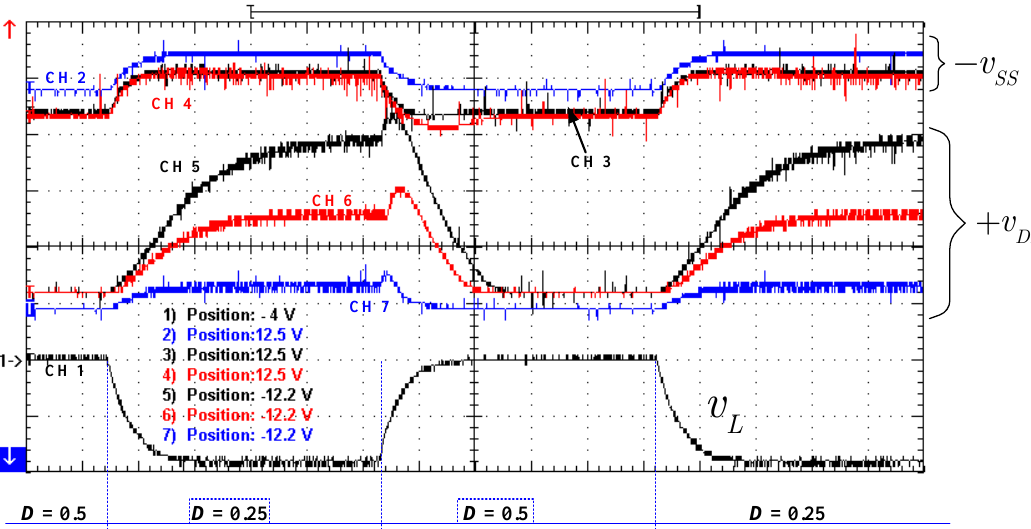
Figure 11. Vertical scale CH 1: 2 V/div, zero position – 4 V. Vertical scale CH 2 – CH 4: 200 mV/div, zero position 12.5 V. Vertical scale CH 5 – CH 7: 200 mV/div, zero position – 12.2 V. Horizontal scale: 10